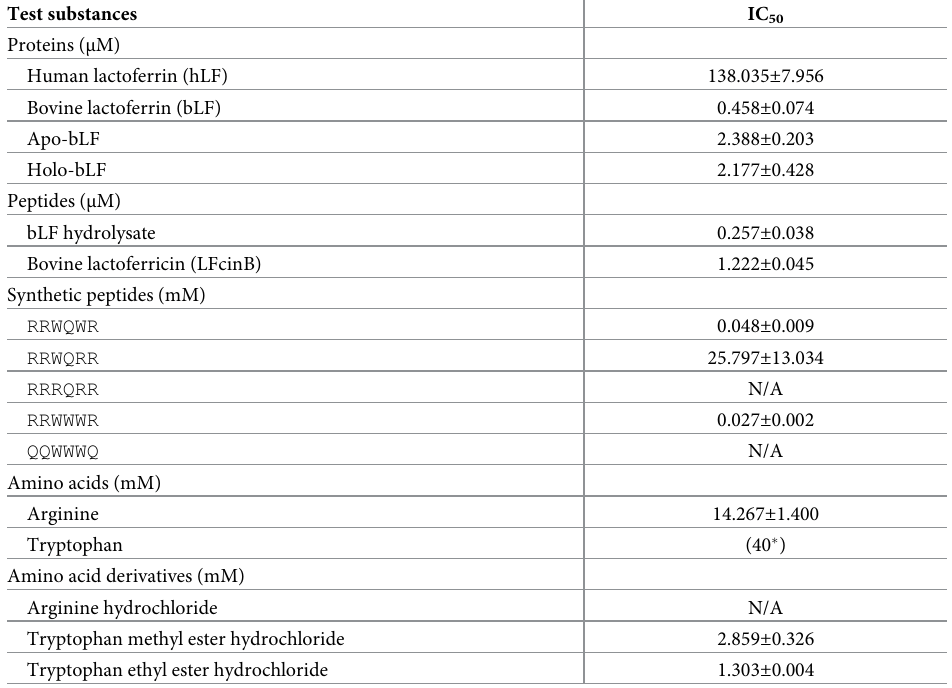
Table 1. Antimicrobial activity (IC 50 ) of test substances used in this study against Streptomyces scabiei S58.